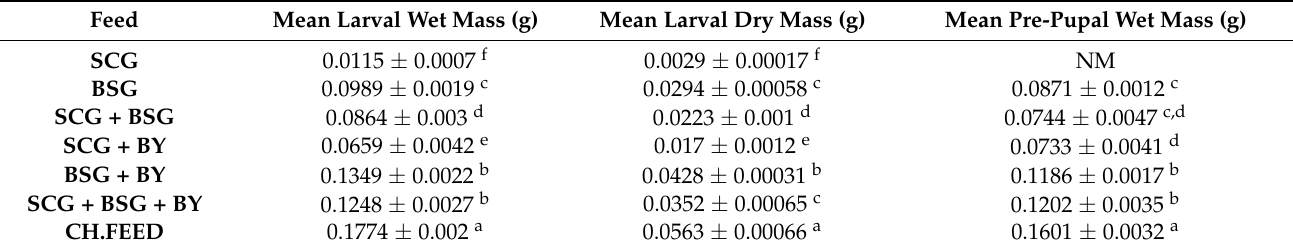
Table 3. Mean larval and pre-pupal wet and larval dry mass of the BSF larvae reared on SCG, BSG, BY and their mixtures (mean ± standard error, n = 4). Mean values followed by different letter in the same column vary significantly ( p < 0.05). NM: Not measured.